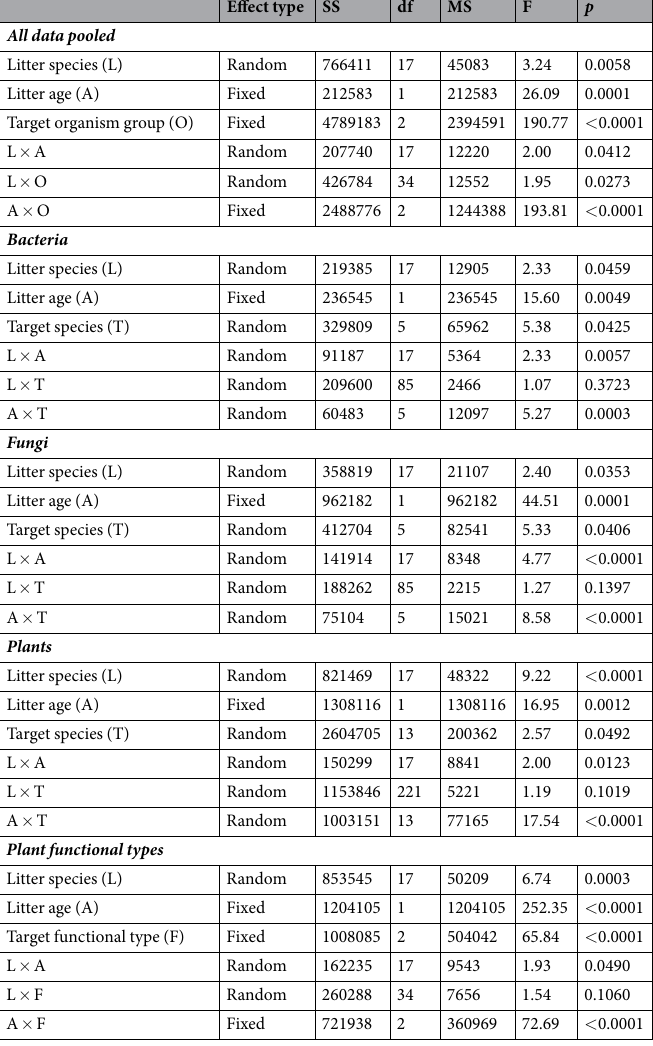
Table 1. Summary of the Generalized Linear Mixed Models (GLMM) testing for main and 2 nd order interactive effects of litter species (random effect) and age (fixed effect, either 0 or 180 days of decomposition) on bioassay results (i.e. growth of plants, fungi and bacteria, expressed as percentage of the untreated control). GLMMs were tested for all data pooled, including a fixed effect of the group of organisms (3 levels), and separately for plants, fungi and bacteria, including a random effect of target species. In the case of plants, a further GLMM was tested, including the effect of target functional type (3 levels: annual, perennial and